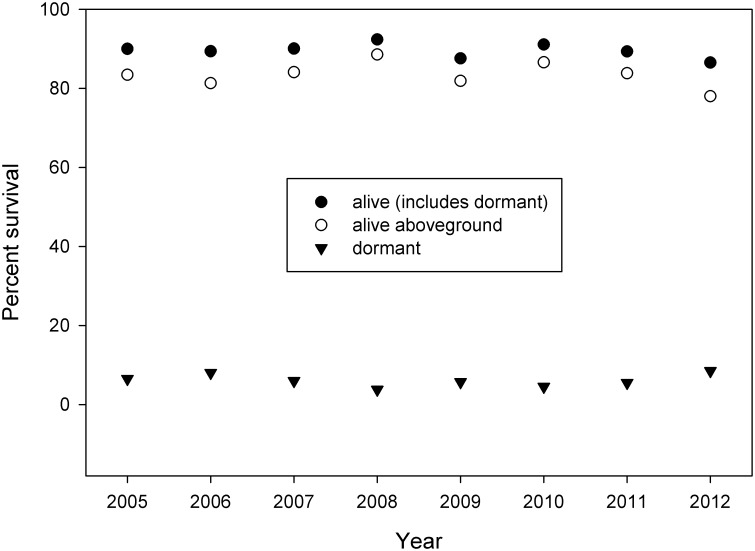
Annual survival of E. rosescens from 2005 to 2012.Percent survival is shown for three classifications: all live individuals including dormant plants, plants alive aboveground, and plants alive but dormant.